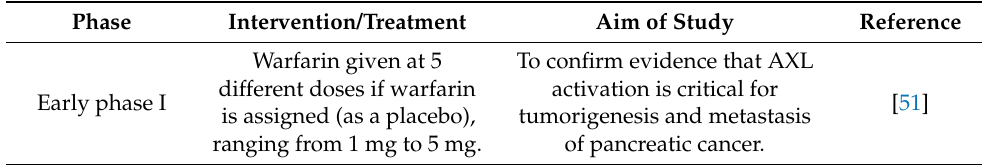
Table 4. Summary of selected ongoing nano-trials in pancreatic